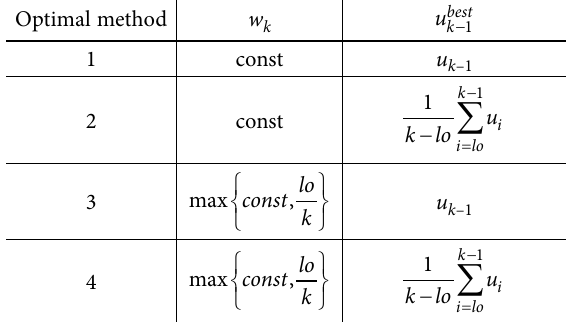
Table 6. Parameter combinations of four type’s heuristic optimization Optimal method